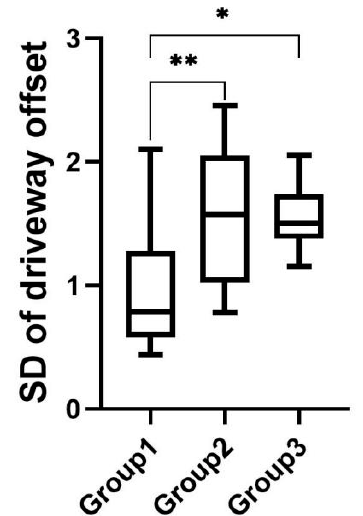
Figure 11. Workload in telephone task. ** indicates significant difference ( p < 0.01).